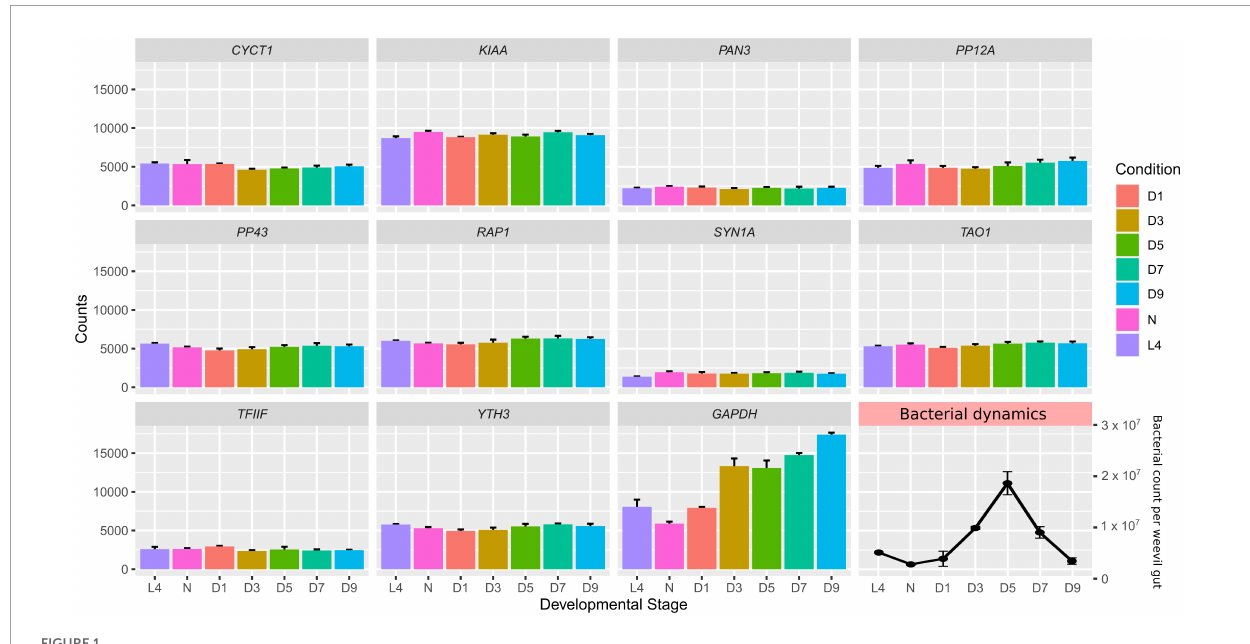
FIGURE1 Expression profile of all candidate housekeeping genes in Sitophilus oryzae gut-bacteriome samples analyzed by transcriptomics at various developmental stages. L4: larval stage 4; P: pupae; D1: 1-day-old adults; D3: 3-day-old adults; D5: 5-day-old adults; D7: 7-day-old adults; D9: 9-day-old adults. Data represent normalized counts at each developmental stage (Ferrarini et al., 2023). Error bars represent standard deviation. Bacterial dynamics is represented in the bottom right corner, adapted from Dell’Aglio et al. (2023).